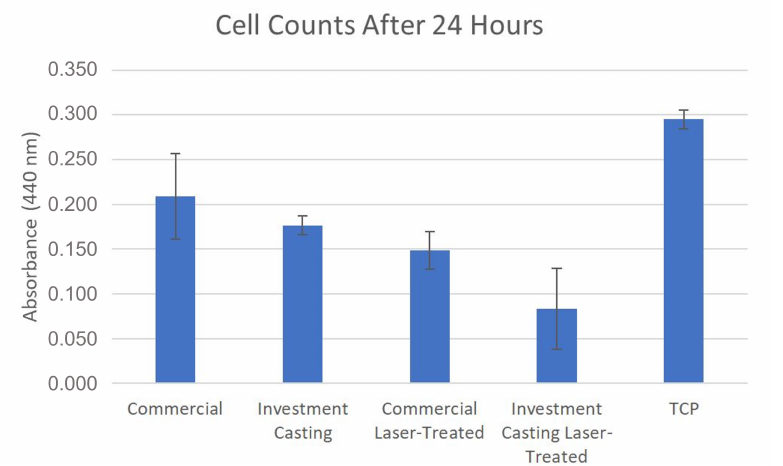
Figure 10. Number of viable cells at the end of 24 h according to absorbance values with a wavelength of 440